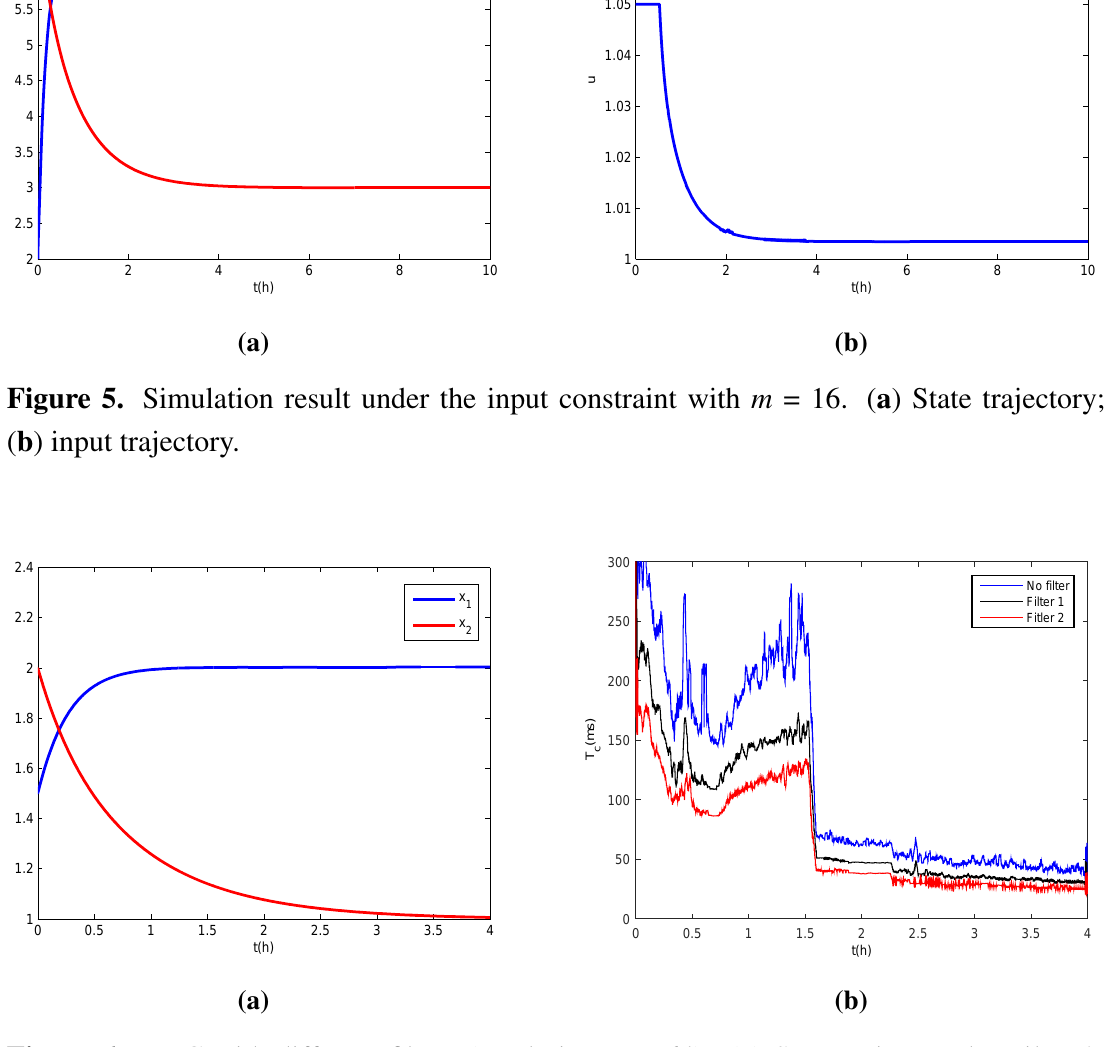
Figure 6. MPC with different filters (resolution m = 64). ( a ) State trajectory by Filter 2; ( b ) computational time